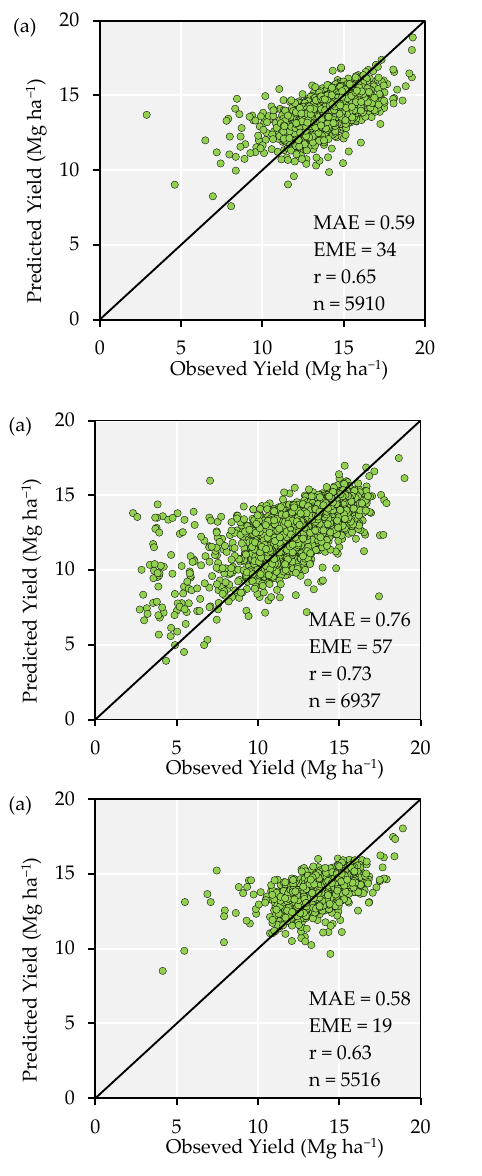
Figure 14. Performance analysis of test dataset with the features spectral bands + TPI + TWI in two approaches of model calibration, ( a ) whole-field and ( b ) site-specific models, in the scenario of the season 2019. Observation: MAE (mean absolute error) is expressed in Mg ha −1 , EME (estimative mean error) in Kg ha −1 , and r is the correlation coefficient.